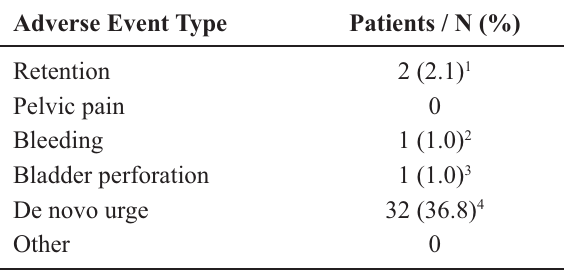
Table 5 – All adverse events by patient (n =